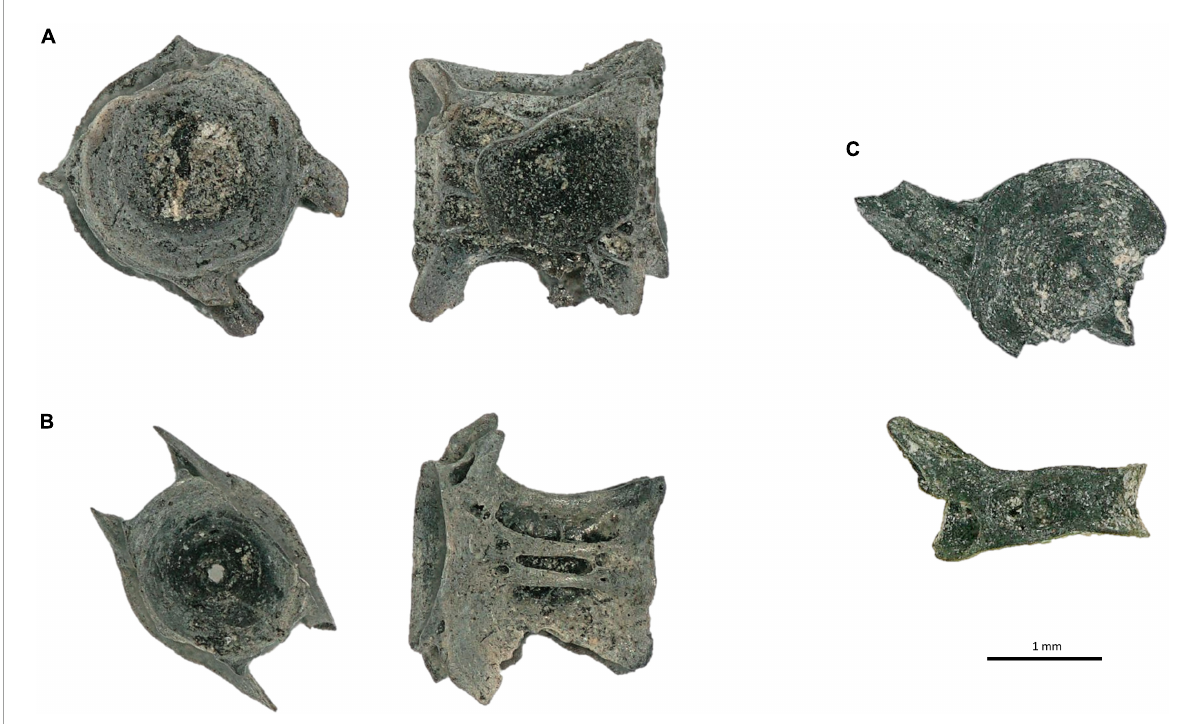
FIGURE10 Three fish vertebrae recovered from SU109: (A–C) present a top and side view of each specimen.